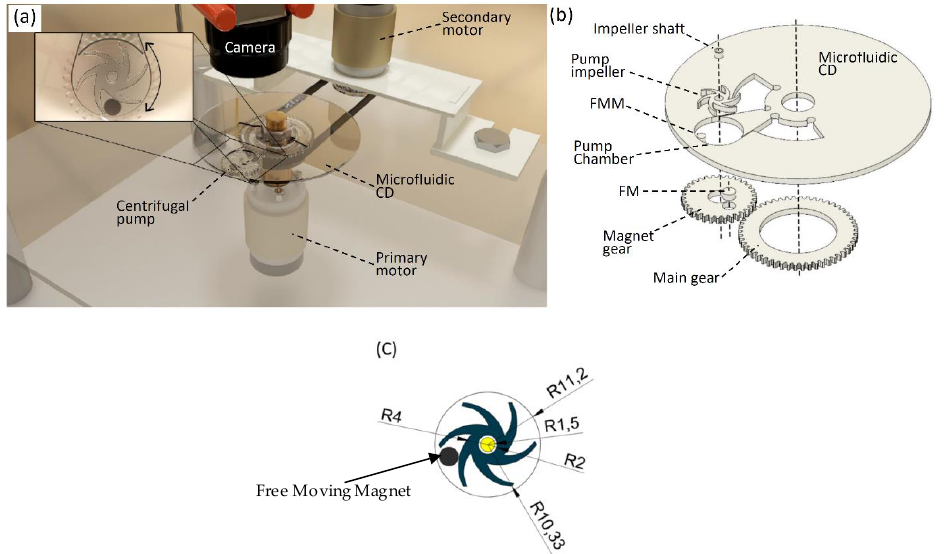
Figure 1. Developed centrifugal pump on microfluidic compact discs (CDs): ( a ) Dual-motor spinning system, mounted microfluidic CD, and integrated centrifugal pump. The top left corner shows a zoomed view of the pump with the free moving magnet installed and the possibility of bidirectional motion for the impeller; ( b ) 3D picture shows the main components of the developed centrifugal pump; and ( c ) the impeller’s design showing the free moving magnet, dimensions in mm.